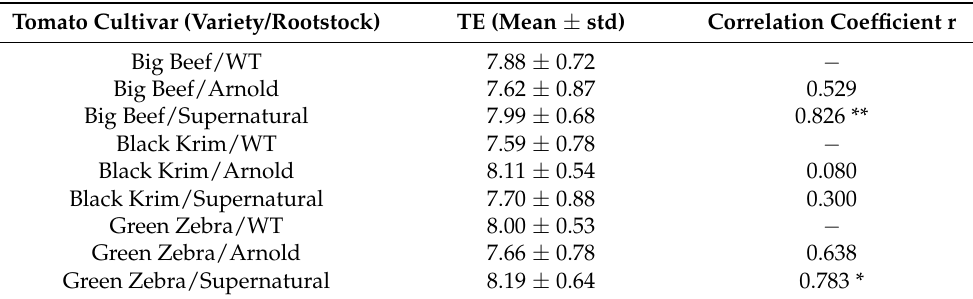
Table 4. Antioxidant capacity of tomato extracts as analyzed by the DPPH assay. Antioxidant capacity was calculated as trolox equivalents (TE; µ mol/g tomato dry weight). Analysis using Pearson correlation showed that the antioxidant capacity was strongly correlated for Big Beef grafted onto Supernatural. A correlation coefficient of r < − 0.7 or r > 0.7 was considered a strong correlation. Tomato Cultivar (Variety/Rootstock) TE (Mean ± std) Correlation Coefficient